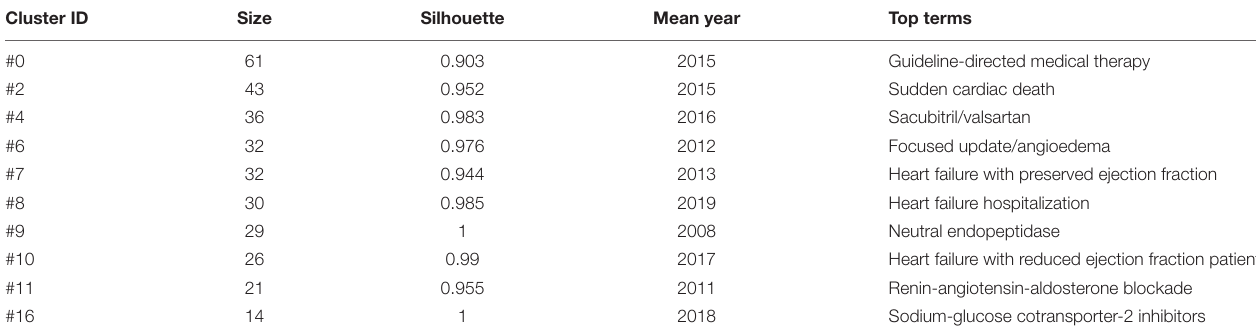
FIGURE 9 | CiteSpace visualization of the cluster analysis of the co-cited literature involved in ARNI studies in the cardiovascular system. (A) Cluster analysis of co-cited references; (B) Timeline distribution of clusters. TABLE 7 | The 10 co-cited reference clusters of ARNI studies in the cardiovascular